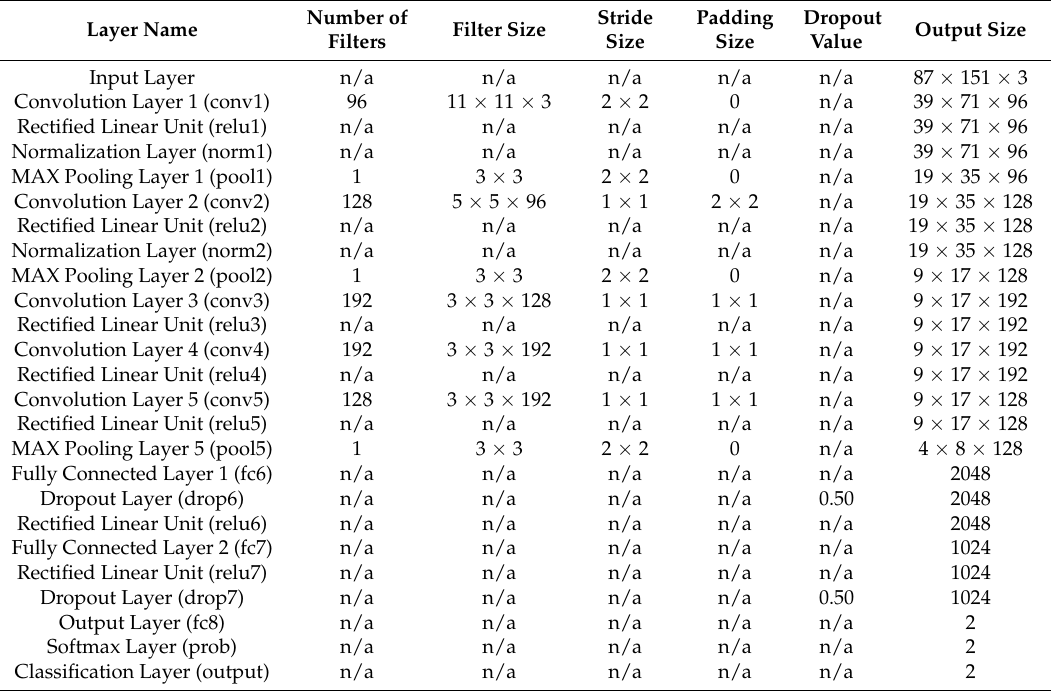
Table 3. Description of customized Alex network for PAD